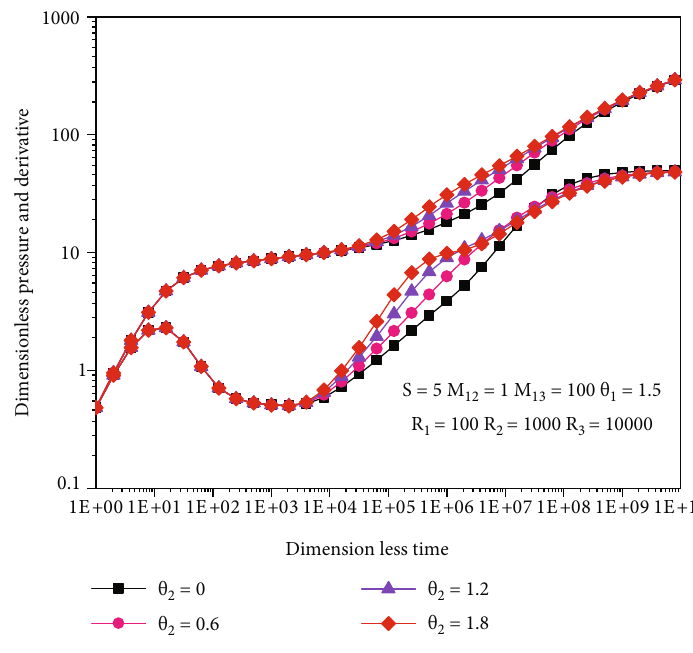
Figure 7: In fl uence of the storage capacity change index in the three-zone homogeneous radial composite transition zone on the well bottom pressure